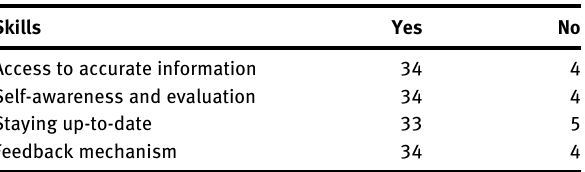
Table  : Results of a phone interview with yes or no questions showing if certain skills are acquired by students related to key concepts of “ Next Generation Medical Education ” in IUE Faculty of